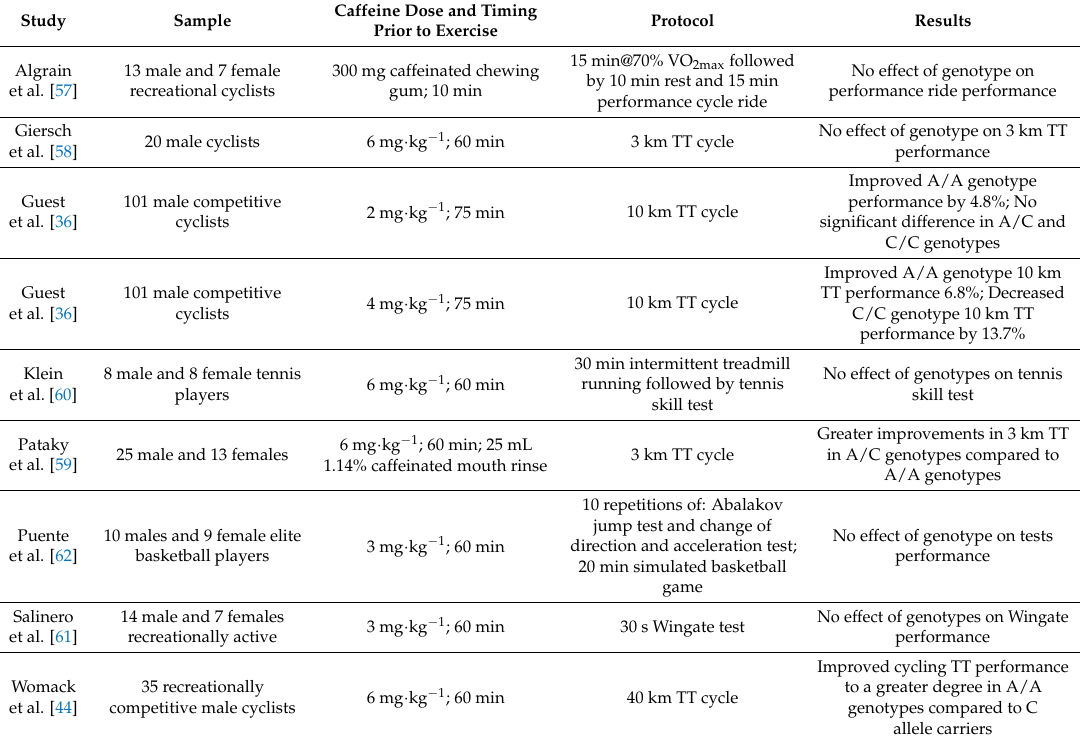
Table 2. Studies investigating the effects of CYP1A2 genotype on time-trial performance following caffeine